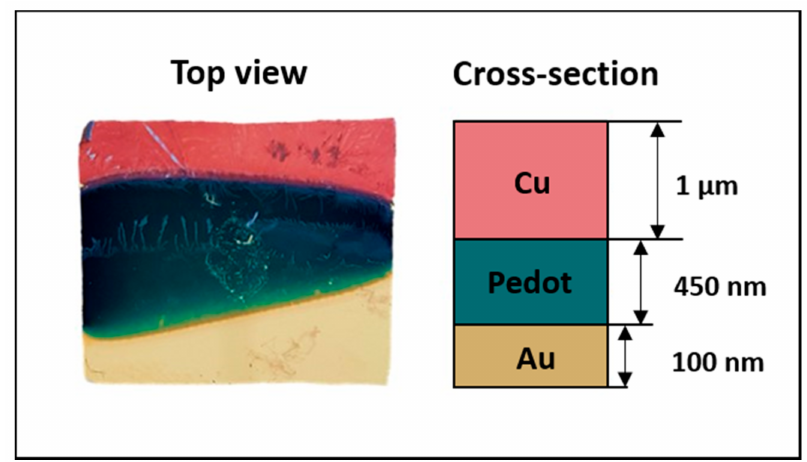
Figure 6. Image of the specimen Cu/PEDOT/Au.